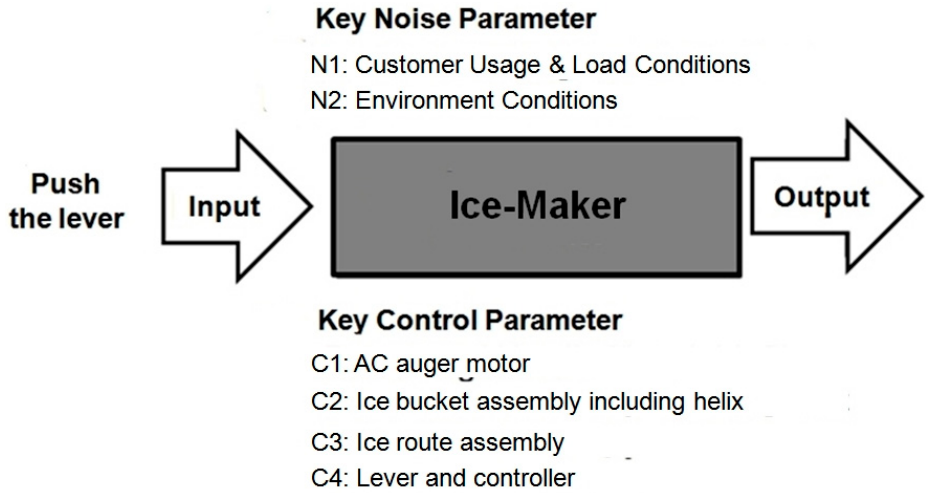
Figure 2. Robust design schematic of a mechanical system, such as an ice-maker.